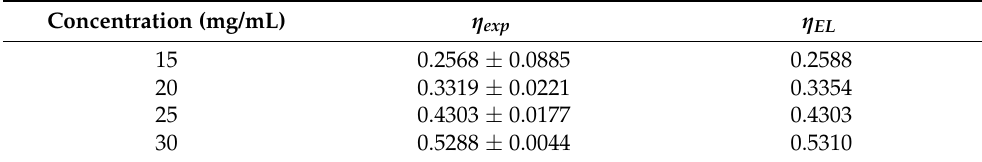
Table 6. Comparison of the dimensionless experimental values of alignment viscosity and calculated from EL at different concentrations.